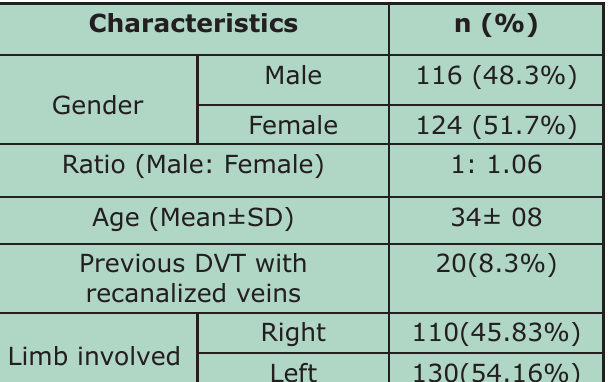
Table-I: Demographic data.